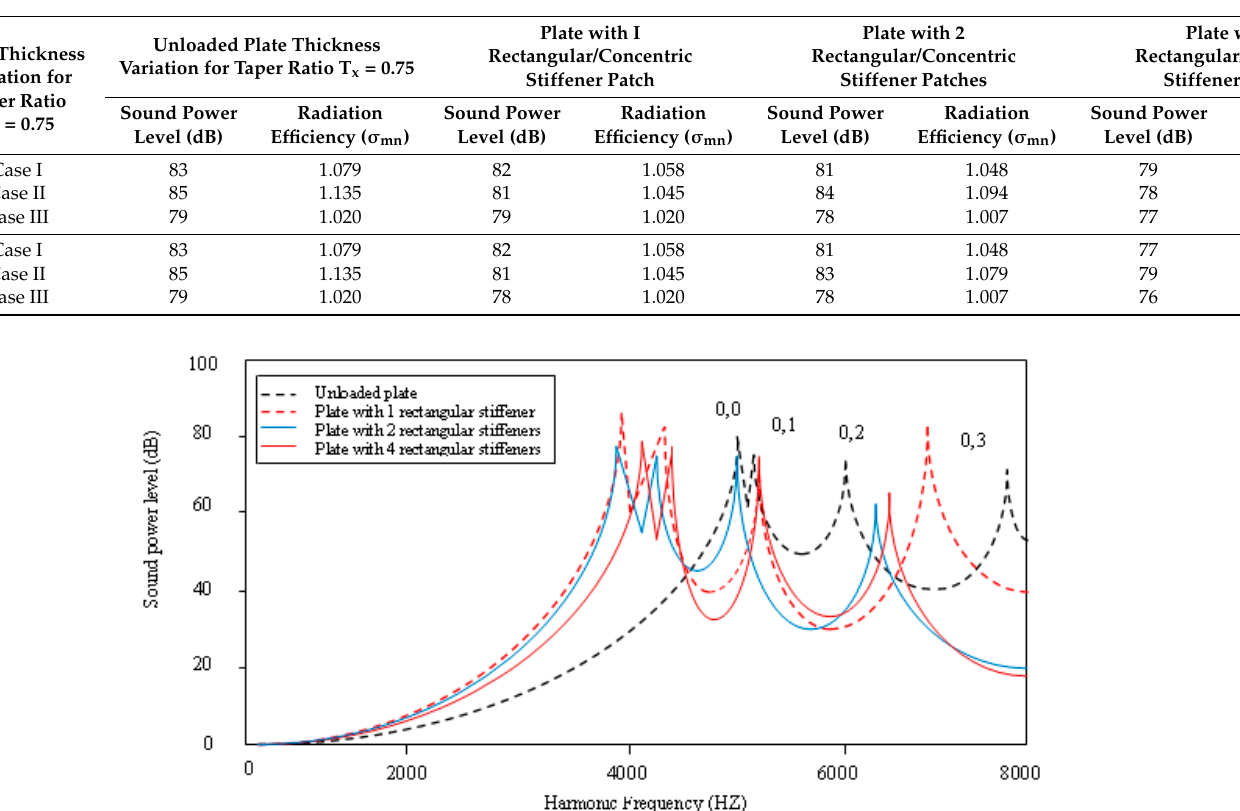
Table 7. Numerical comparison of peak sound power level and radiation efficiency for annular plate having different parabolically thickness variations with different attachments of rectangular and concentric stiffener patches for T x = 0.75.